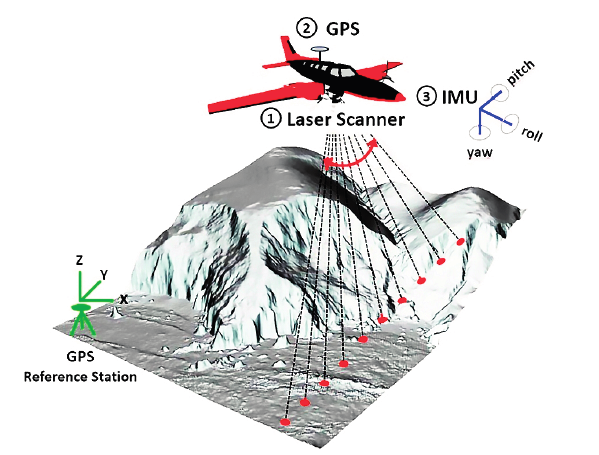
Figure 1. Basic principle of spatial positioning for ALS system (modified from